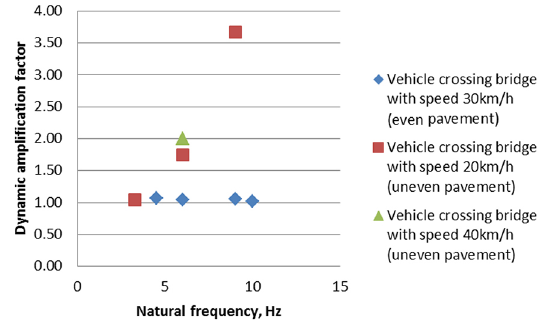
Fig. 21. Natural frequency dependence on span length